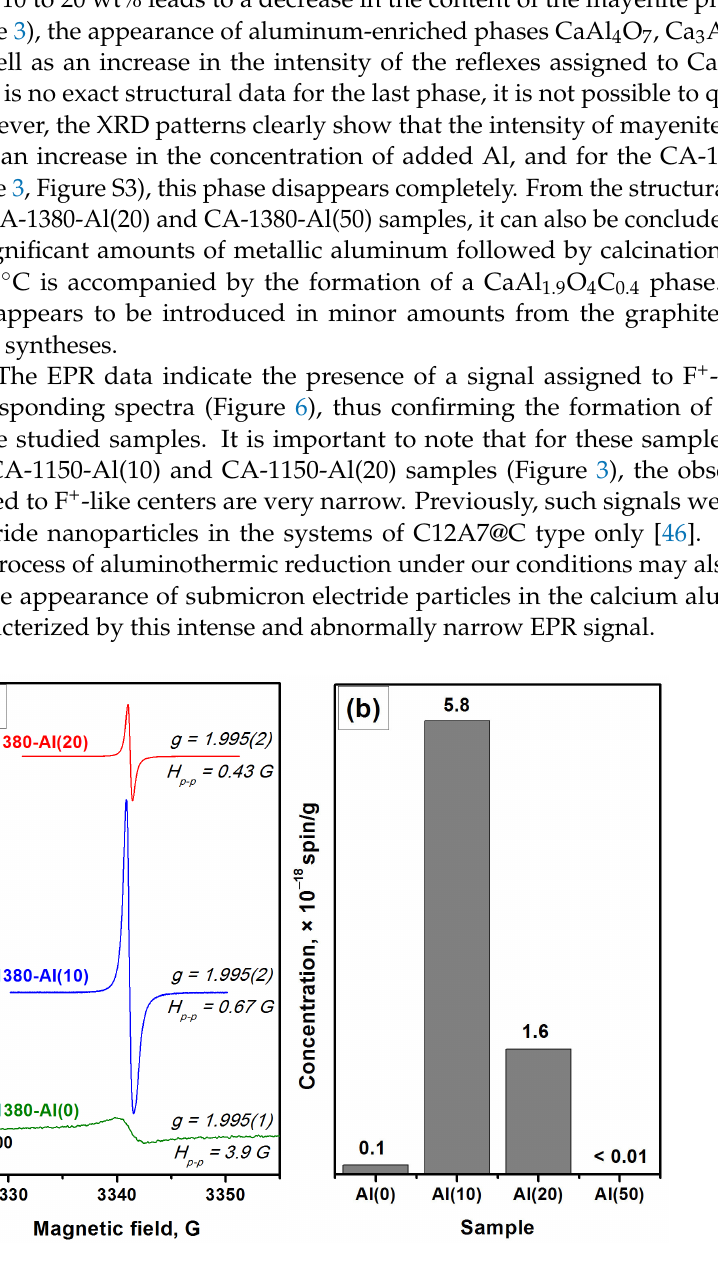
Table 3. Lattice parameter ( a ), phase composition, and specific surface area (SSA) of the mayenite samples calcined in an Ar atmosphere at 1380 °C.